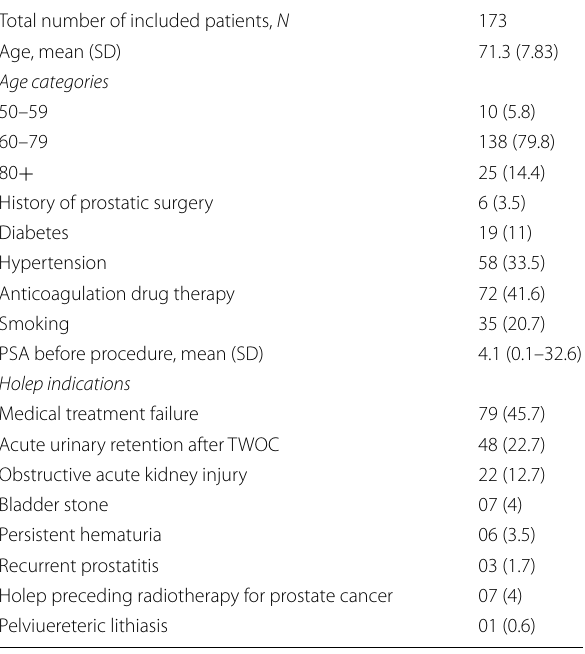
Table 1 Preoperative baseline characteristics